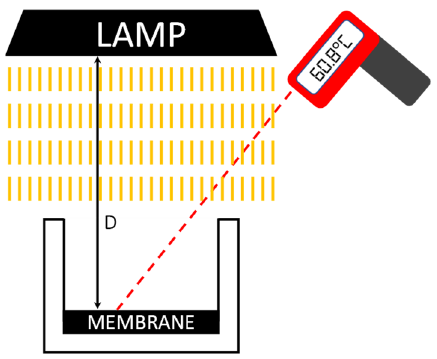
Figure 1. Sketch of the setup used for surface temperature measurements.